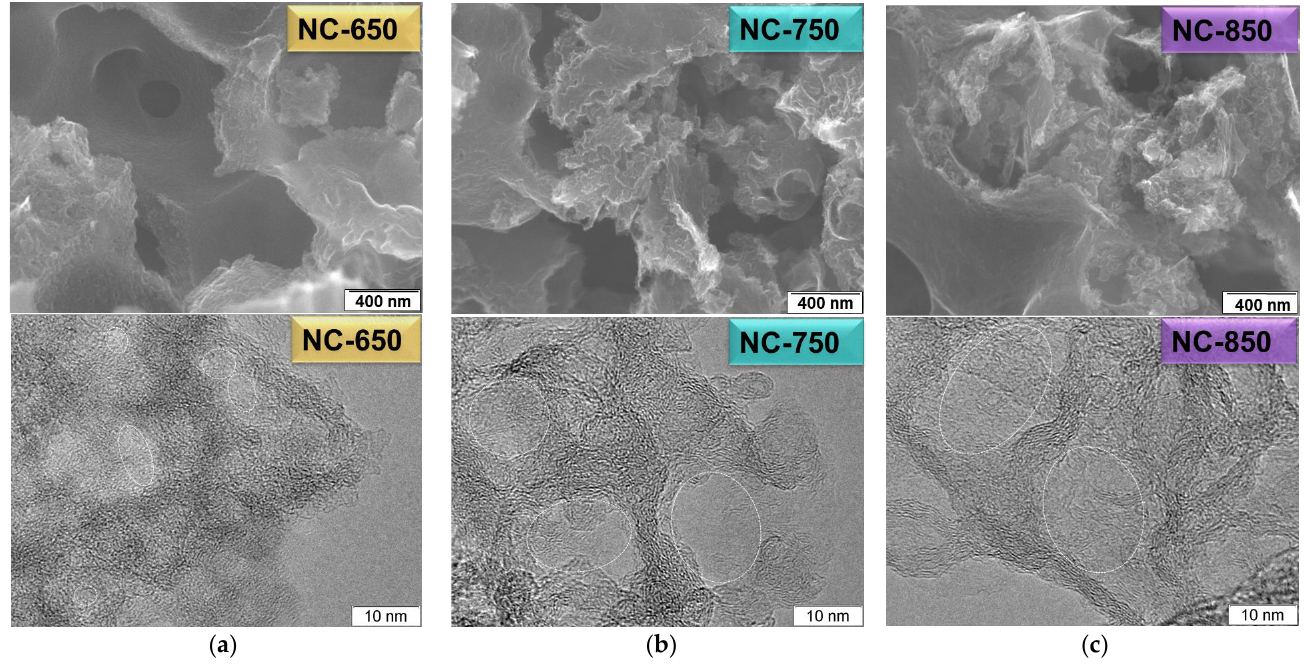
Figure 2. SEM ( upper ) and TEM ( down ) images of NC-650 ( a ), NC-750 ( b ), and NC-850 ( c ). Curved carbon walls organize spongy materials with a system of open and closed pores. At first glance, all the samples have a very similar morphology and are clusters of irregularly shaped agglomerates with a loose surface. Upon closer examination, it is seen that the surface friability was formed due to holes, which were more probably caused by the removal of template particles. Some of the pores in the NC materials repeat the shape of the template nanoparticles. Thus, an increase in the synthesis temperature leads to the growth of template nanoparticles due to their agglomeration. Consequently, macropores in NC materials also visually grow in size. According to the TEM images, the maximum pore size is ca. 10 nm in NC-650, ca. 20 nm in NC-750 and ca. 30 nm in NC-850. At 650 °C, the pyrolysis product of calcium tartrate contains a mixture of CaO and CaCO 3 nanoparticles. As shown in [34], the subsequent decomposition of CaCO 3 leads to the formation of gaseous carbon oxides, which etch the grown carbon layers in the process of their release. This etching process can lead to the formation of defects and the opening of pores. The TEM images of the NC materials demonstrate disordered structures of curved carbon walls; stacks of carbon layers visually become more graphitized with an increase in temperature. Small carbon vacancy defects are likely to heal at